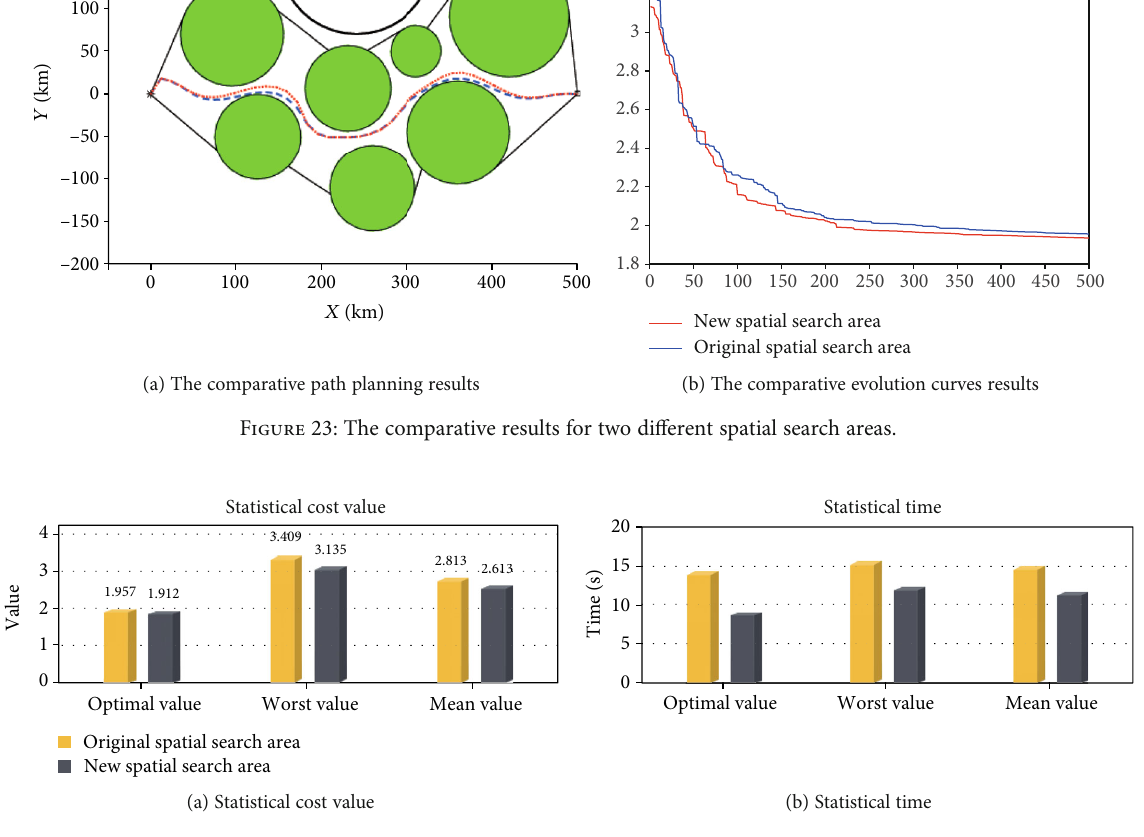
Figure 24: The statistical results of two di ff erent spatial search areas. Table 6: Results comparison for two spatial search